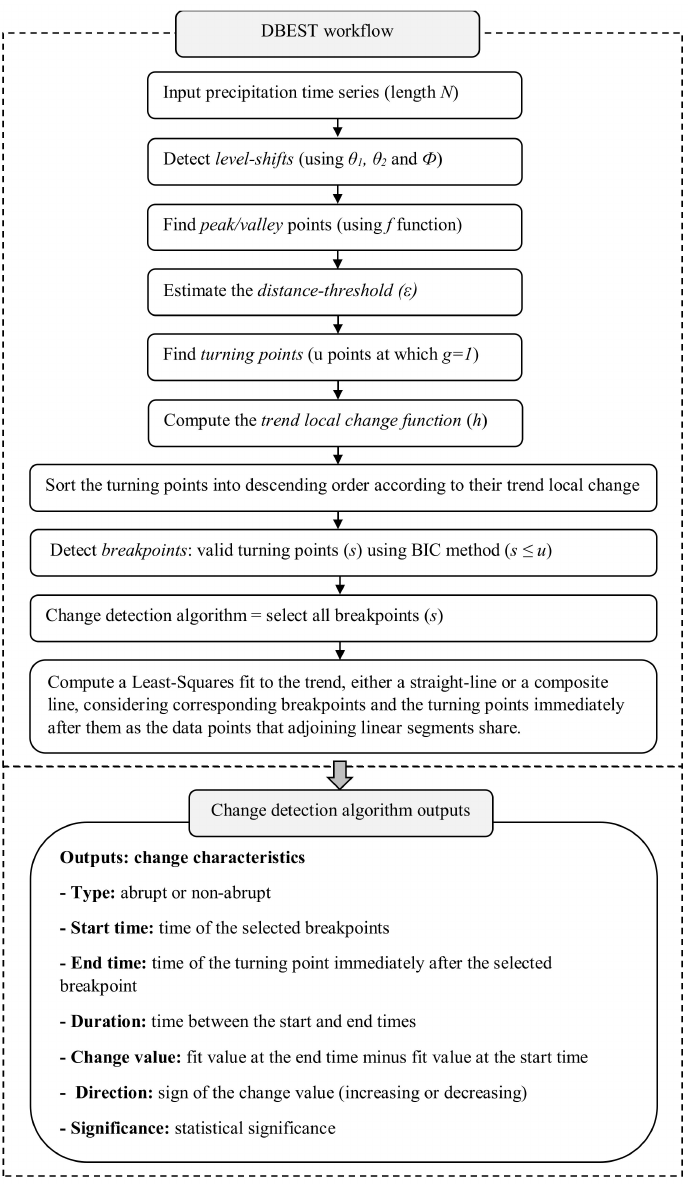
Figure 1. Flowchart of DBEST algorithm for detecting and characterizing changes in pixel-based precipitation datasets (after Jamali et al.